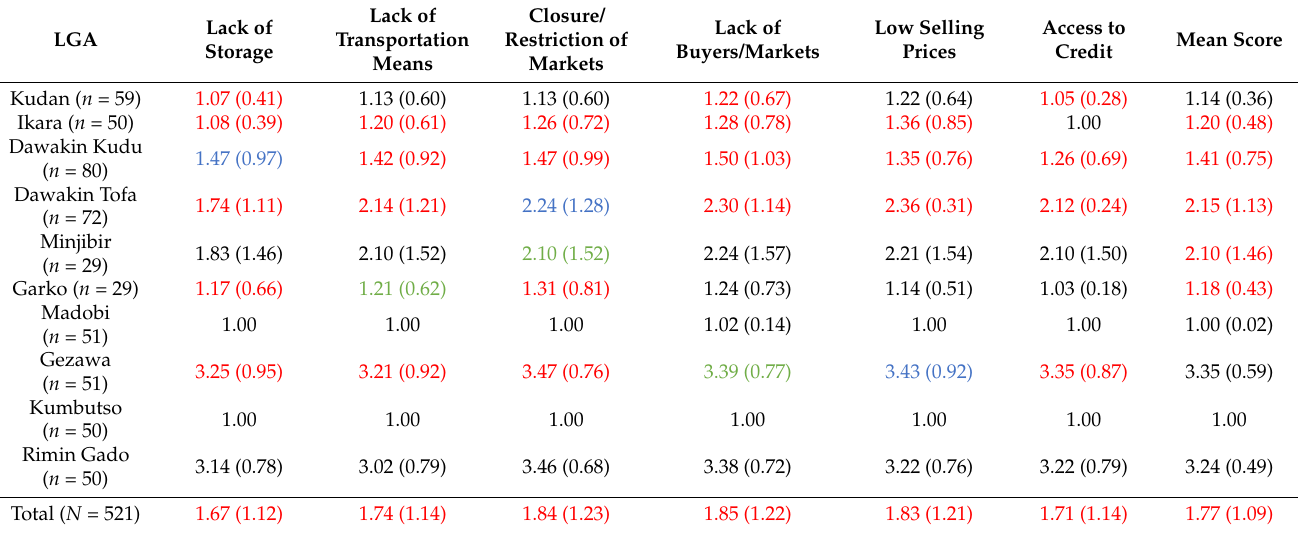
Table 6. Heat map of the scale of challenges experienced by farmers in storage and selling as a result of the COVID-19 pandemic.